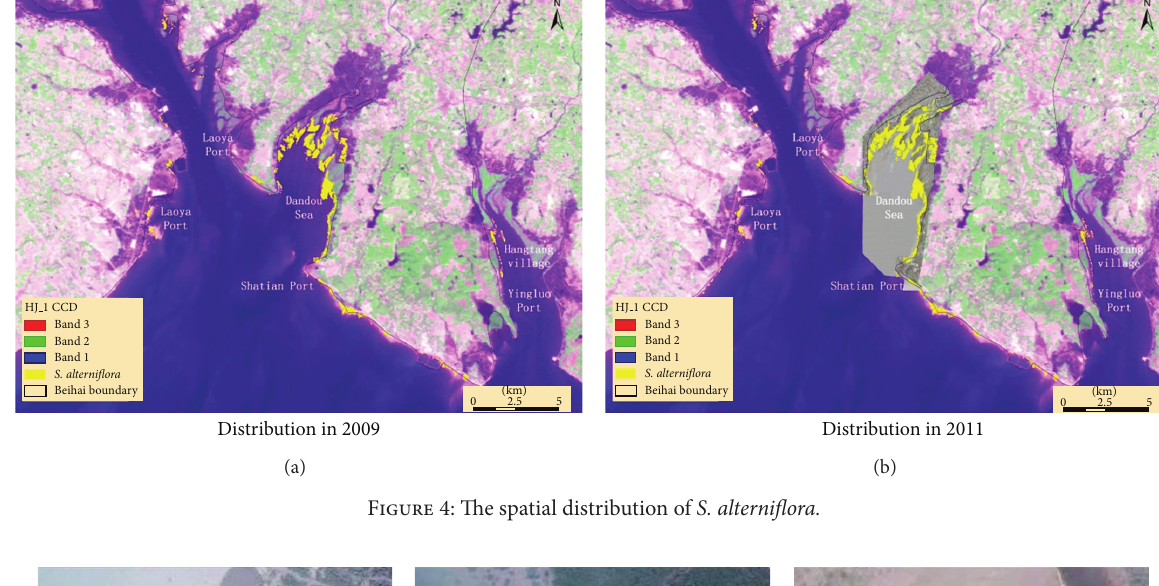
Figure 4: The spatial distribution of S. alterniflora.